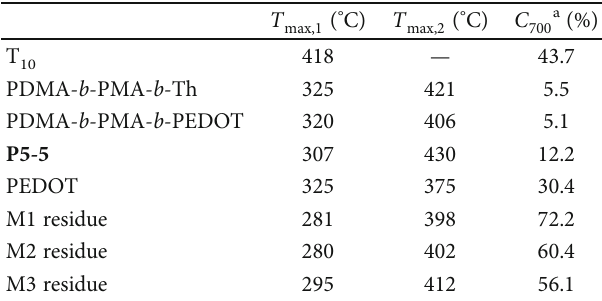
Table 2: Thermogravimetric analysis data of various copolymers and modi fi ed-SWNT residues.